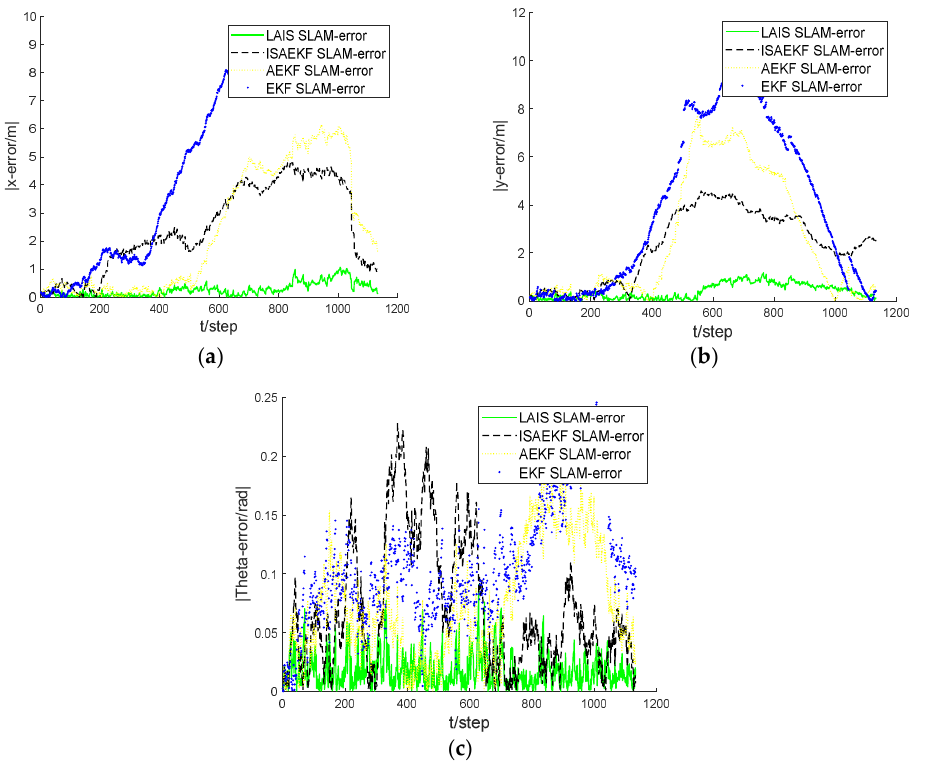
Figure 6. Error of each algorithm when the signpost point is 60 under colored noise. ( a ) x axis direction error. ( b ) y axis direction error. ( c ) Rotation angle error.